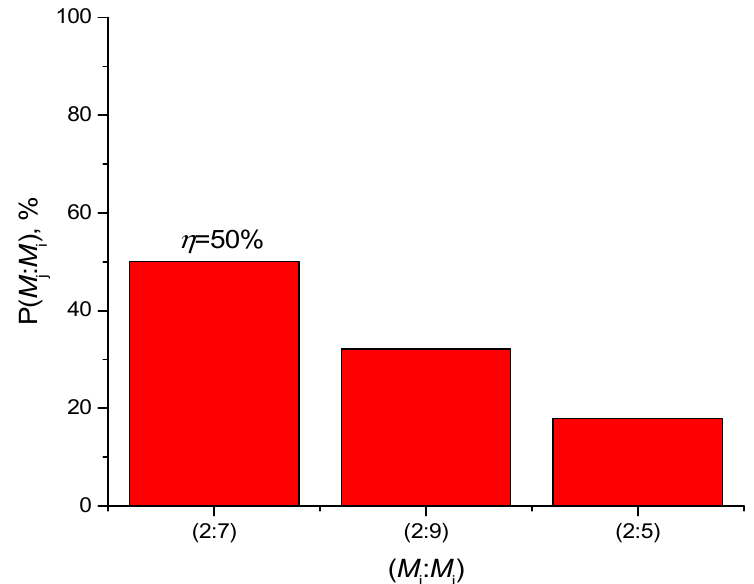
Figure 8. Histogram of probabilities distribution P ( M j , M i ) calculated by using Formula (11) for signals LE, shown in Figure 7.